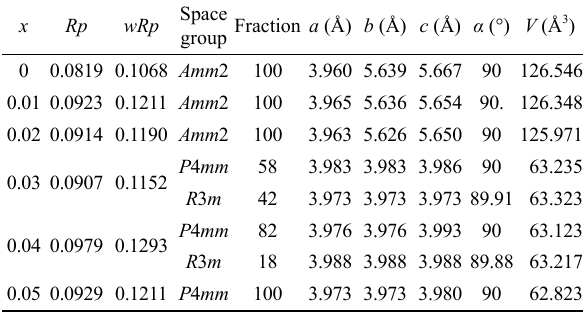
Table 1 Lattice parameters and refinement parameters of the KNN-based ceramics